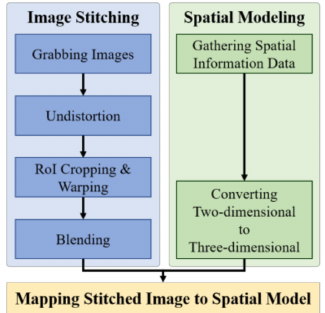
Figure 2. Schematic of the proposed system. RoI: region of interest.